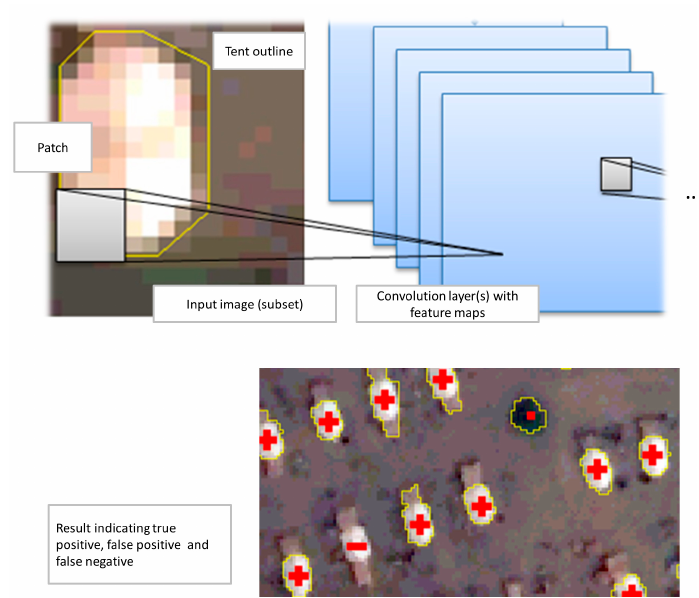
Figure 3. An image patch with a series of filters for CNN training to extract tents and other dwellings in a refugee camp scene ( a ); a small subset showing true positives ( + ), false positive (.), and false negative (-) ( b ), modified from [45] .